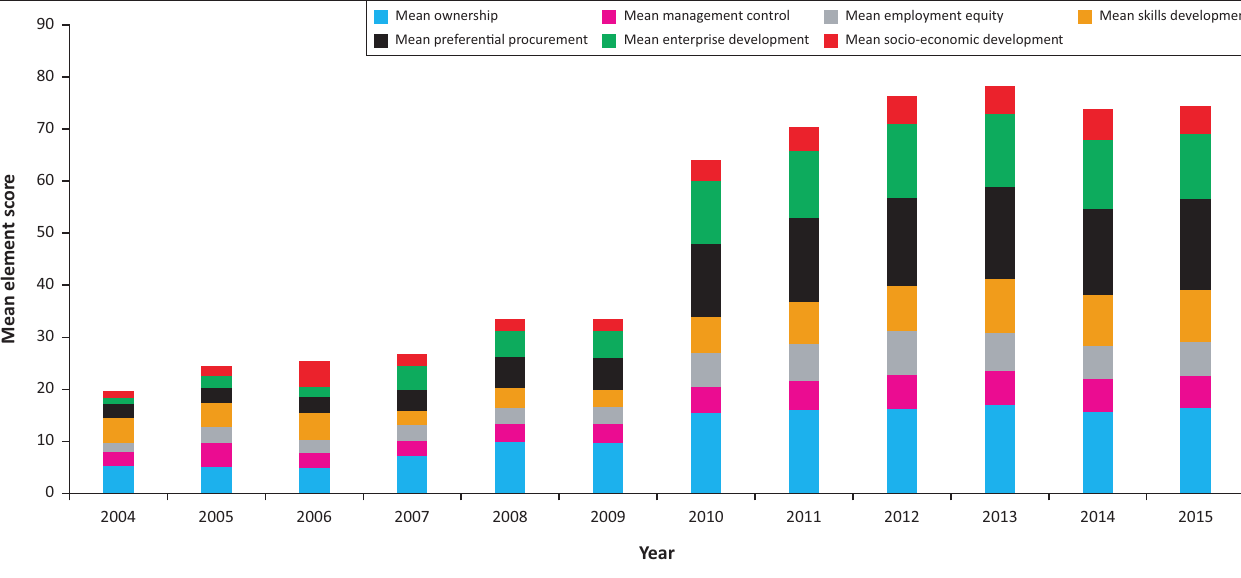
FIGURE 2: Contribution of each element to the mean total Broad-Based Black Economic Empowerment